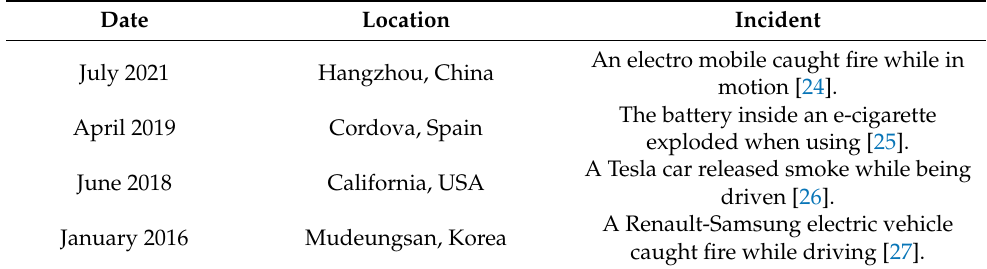
Table 1. The list of typical LIB fire accidents in the operational